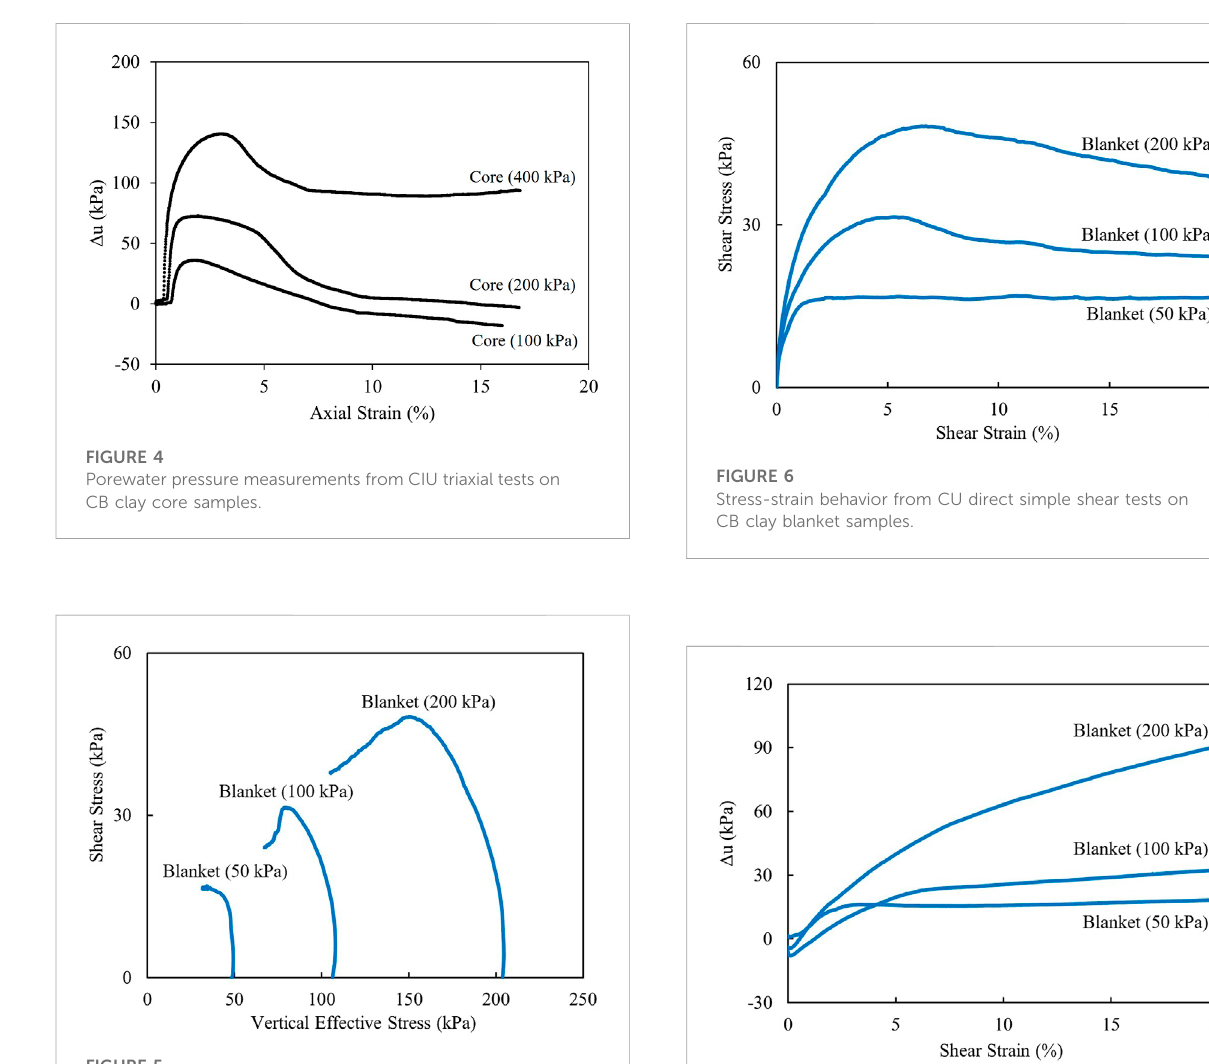
FIGURE 5 Shear stress versus vertical effective stress plot from CU direct simple shear tests on CB clay blanket samples.